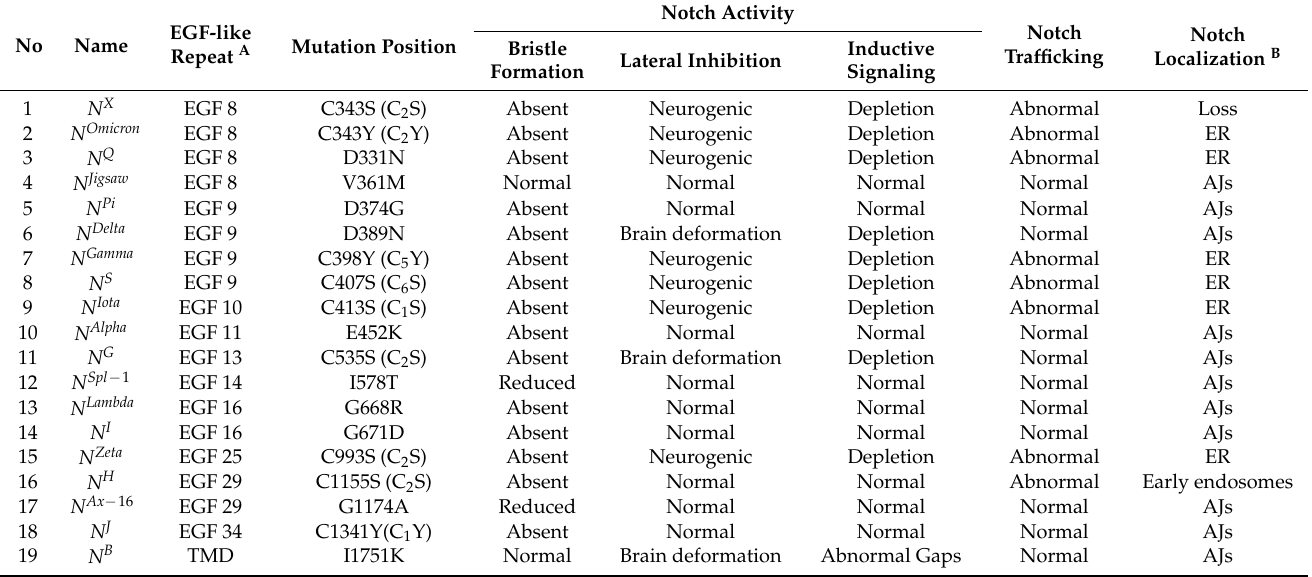
Table 1. Notch missense mutations and their defects.